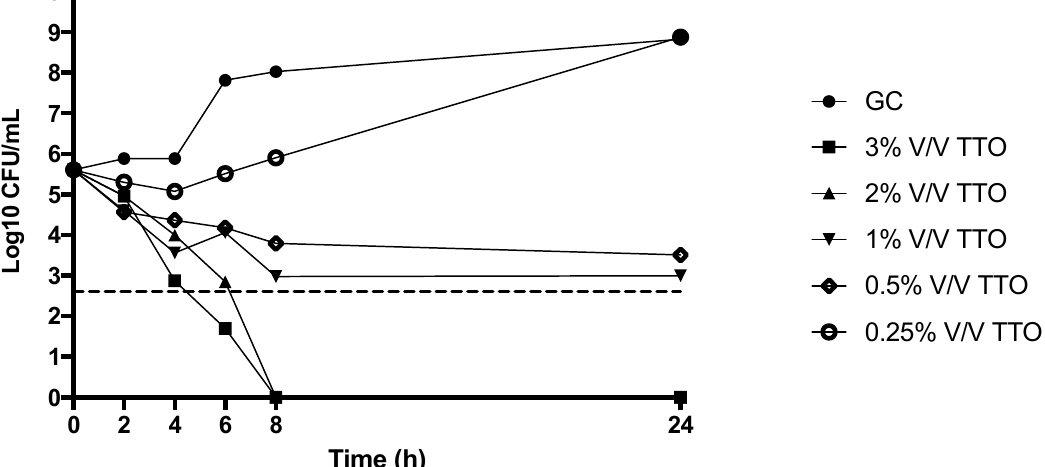
Figure 2. Activity of TTO against MRSA at different concentrations throughout killing study. GC: Growth Control; MRSA: Methicillin-resistant Staphylococcus aureus . Dashed line represents bactericidal activity.